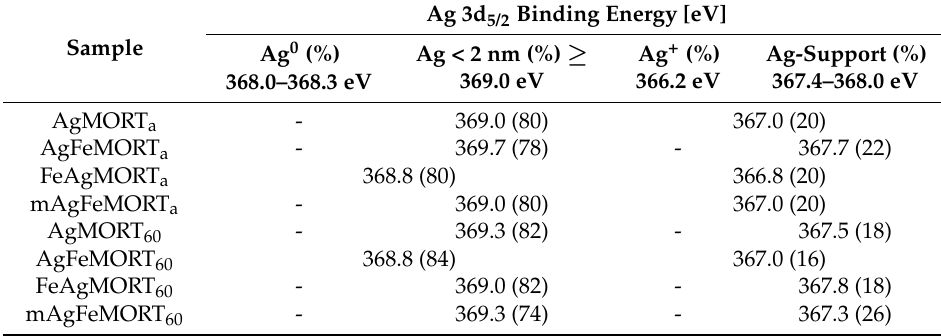
Table 3. Mean peak position of the de-convoluted bands from Ag 3d XPS